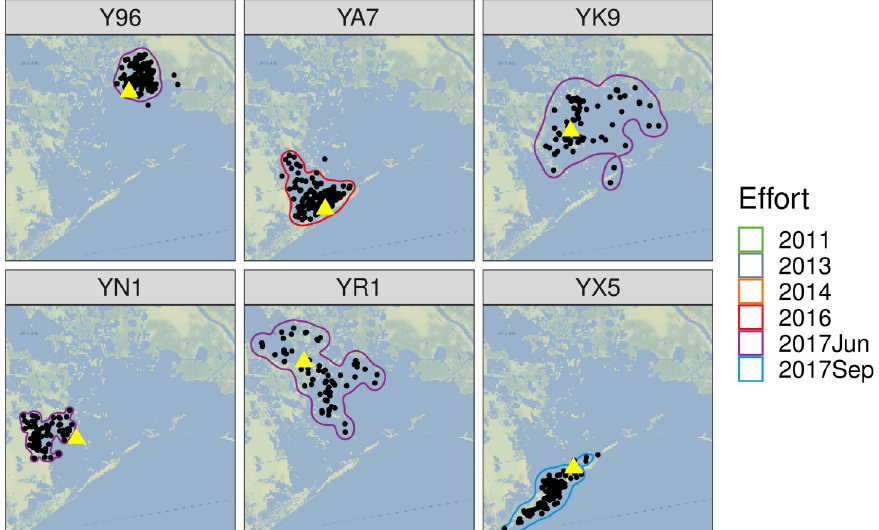
Fig 2. Examples of individual dolphins’ telemetry locations and potential ranging areas from the 2016 and 2017 field efforts. While some dolphins maintained relatively small potential ranging areas throughout the lifetime of their tags (e.g., Y96, YA7, YN1, and YX5), other dolphins showed extended movements within the interior of the basin (e.g., YK9 and YR1). Yellow triangles denote tagging locations. Map tiles used with permission from Stamen Design,